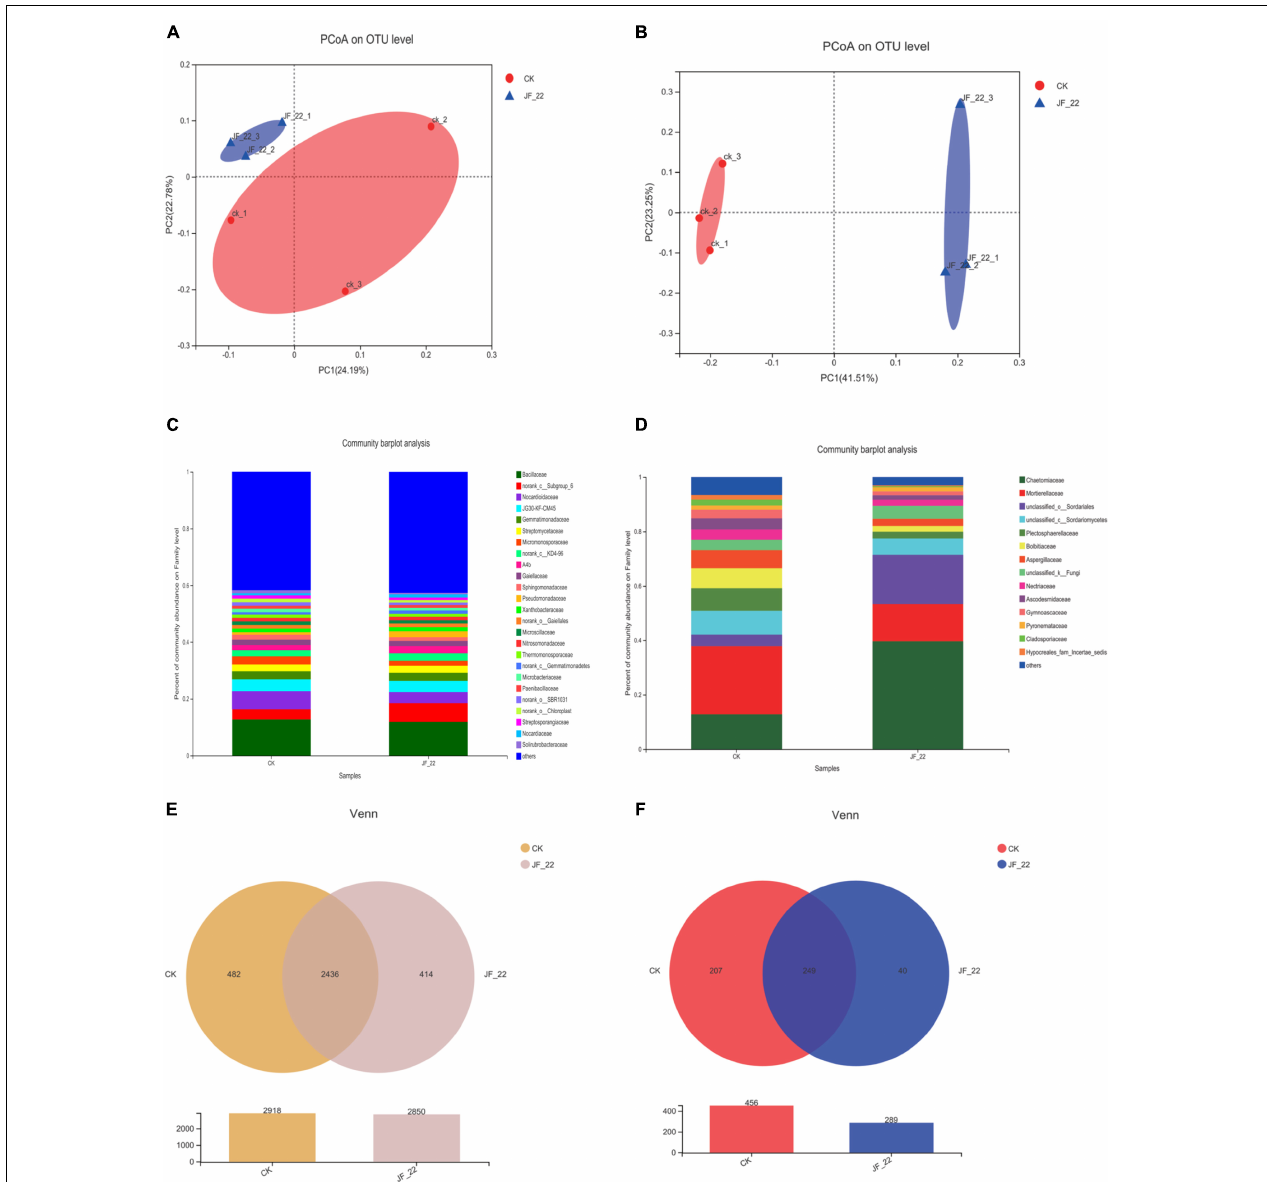
FIGURE 3 | The effect of JF-22 to tomato rhizosphere soil microbial community. (A) PCoA analysis based on the unweighted unifrac distances of bacterial community. (B) PCoA analysis based on unweighted unifrac distances of fungal community. (C) The relative abundance in family of tomato rhizosphere bacterial. (D) The relative abundance in family of tomato rhizosphere fungi. (E) Venn diagram of OTUs between CK- and JF-22 relate bacterial; (F) Venn diagram of OTUs between CK and JF-22 relate fungi.